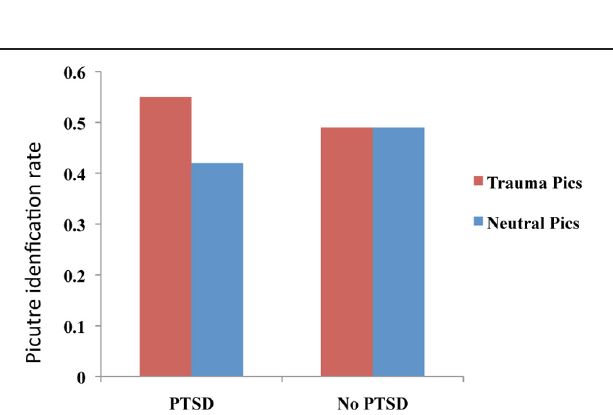
FIGURE 2 | Performance on an implicit memory task (blurred picture paradigm). Patients with PTSD identified more trauma-related blurred images than neutral images. No difference between trauma-related and neutral pictures was observed for the No PTSD group. This figure was created from the data supplied in Table 3; Kleim et al.